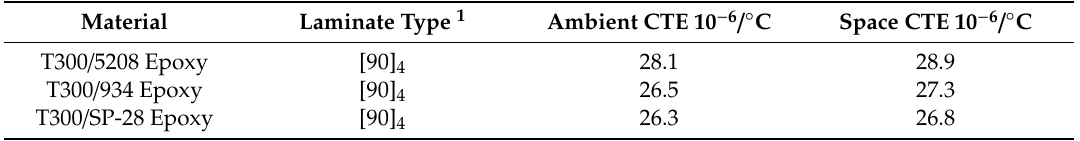
Table 6. A partial list of CTE data obtained from the Long Duration Exposure Facility (LDEF) experiment for CF / Epoxy samples [33].